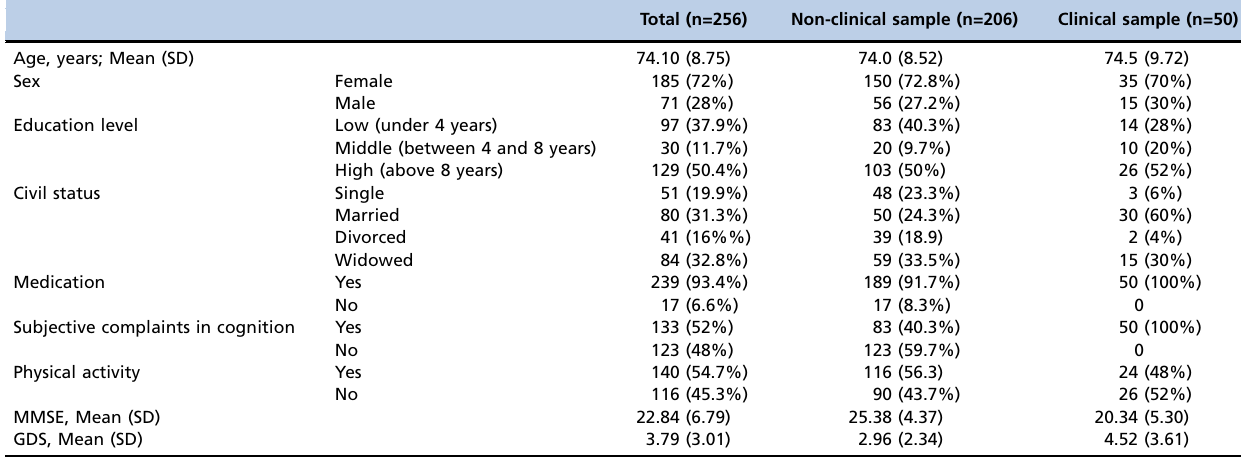
Table 1 - Sociodemographic and clinical data of elderly with and without